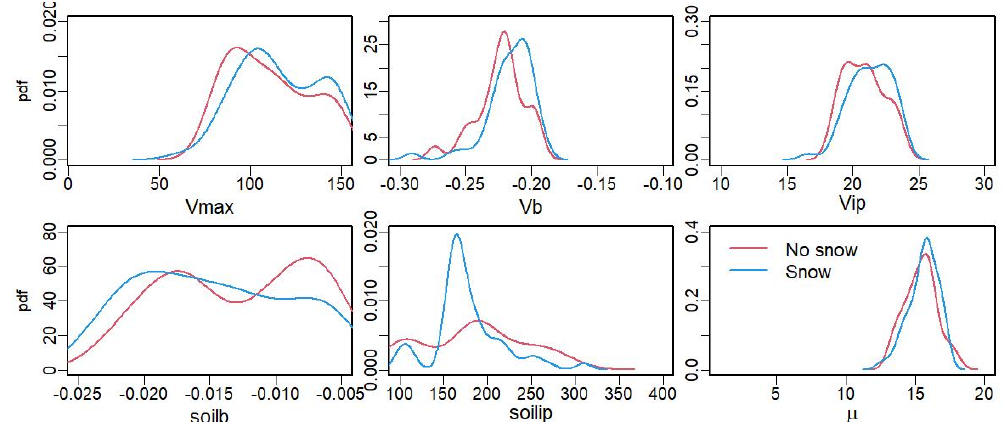
Figure A1. Posterior probability density distributions of the parameters controlling GPP at the Uaf site for the model without (red) and with (blue) snow.